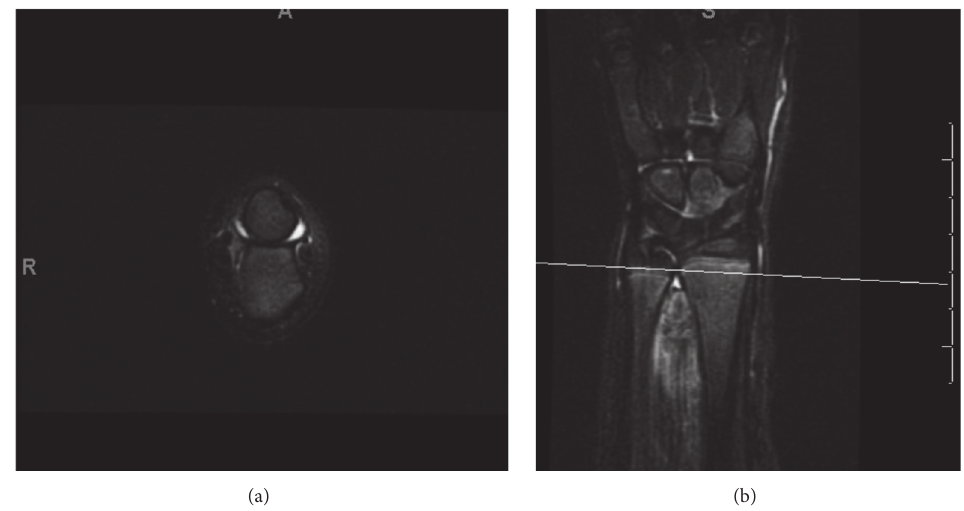
Figure 1: (a) Axial T2 fat suppressed and (b) coronal STIR MRI of the left wrist showing fluid in the distal radioulnar joint